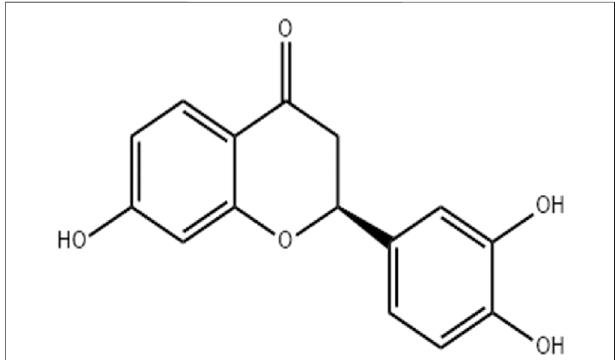
FIGURE 1 | Butin (7,3 ′ ,4 ′ -trihydroxydihydro fl